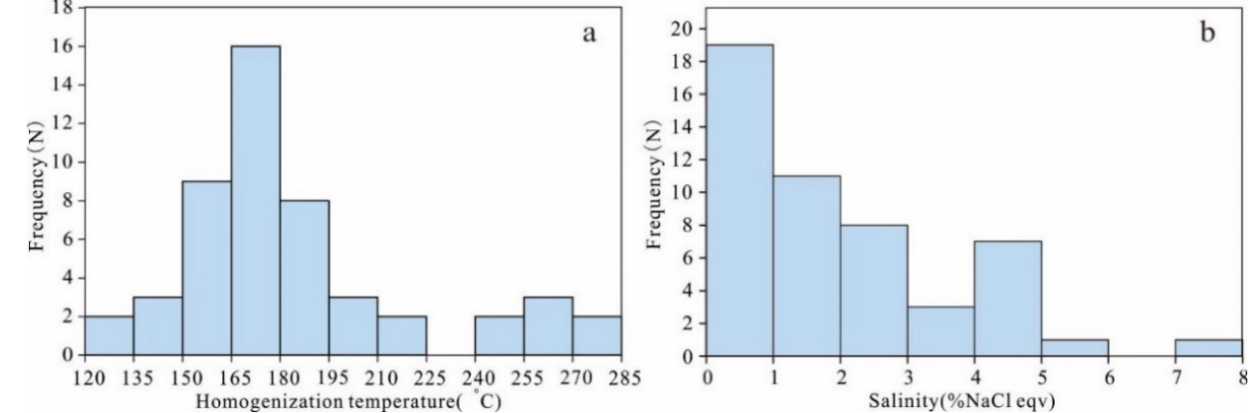
Figure 9. Histograms of ( a ) homogenization temperatures and ( b ) salinities of fluid inclusions in fluorite from the Shuanghuajiang fluorite deposit.